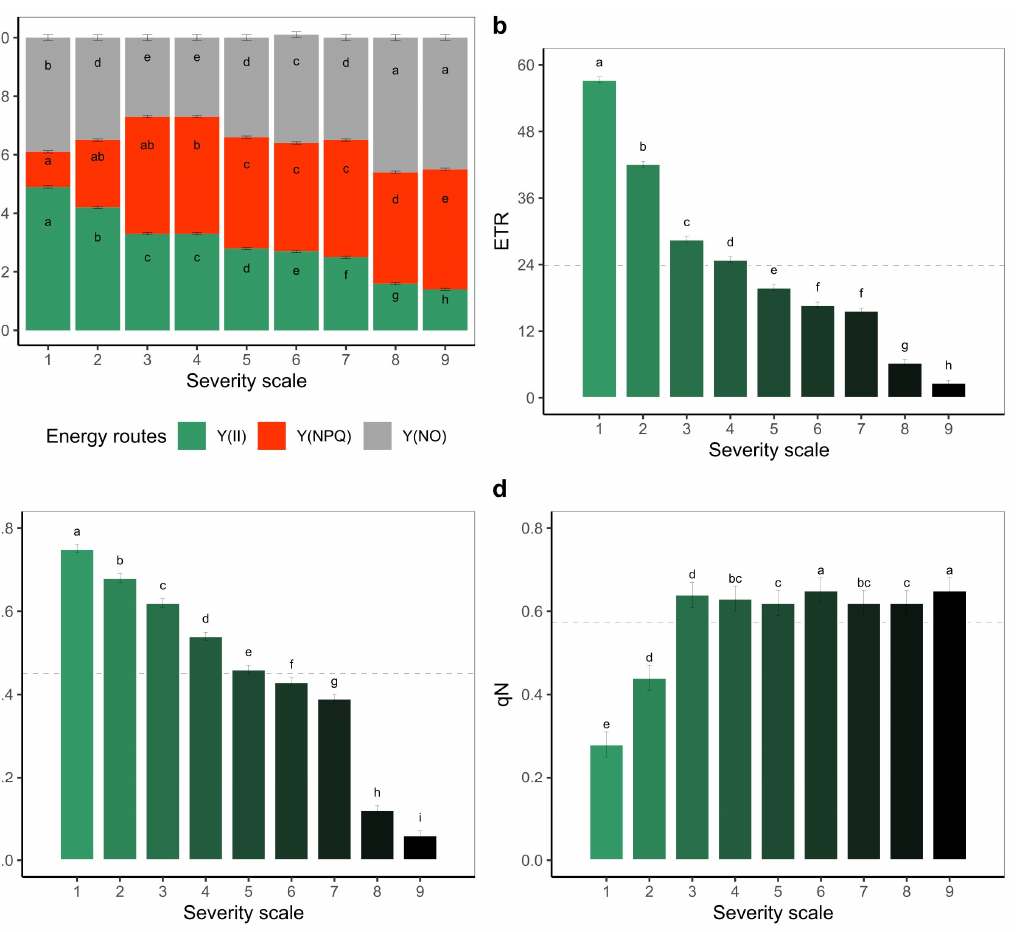
Figure 4. Chlorophyll fluorescence (Chl a ) parameters as a function of an increasing degree of web blight impairment in common bean leaf laminae. Results are shown as ( a ) differences between severity scales in energy allocation ratios; each bar represents unity and they are divided into three complementary PSII performance terms: effective PSII quantum yield Y(II); regulated energy dissipation quantum yield Y(NPQ), and unregulated energy dissipation quantum yield Y(NO); ( b ) apparent electron transport rate (ETR); ( c ) photochemical quenching coefficient (qP); and ( d ) non-photochemical quenching coefficient (qN). a,b,c,d,e,f,g,h,i : Different letters within each severity scale indicate statistical differences according to the Fisher LSD means test ( p < 0.05). The black dotted line in each panel represents the average value of the variable. Results include mean ± SE (n = 1296).